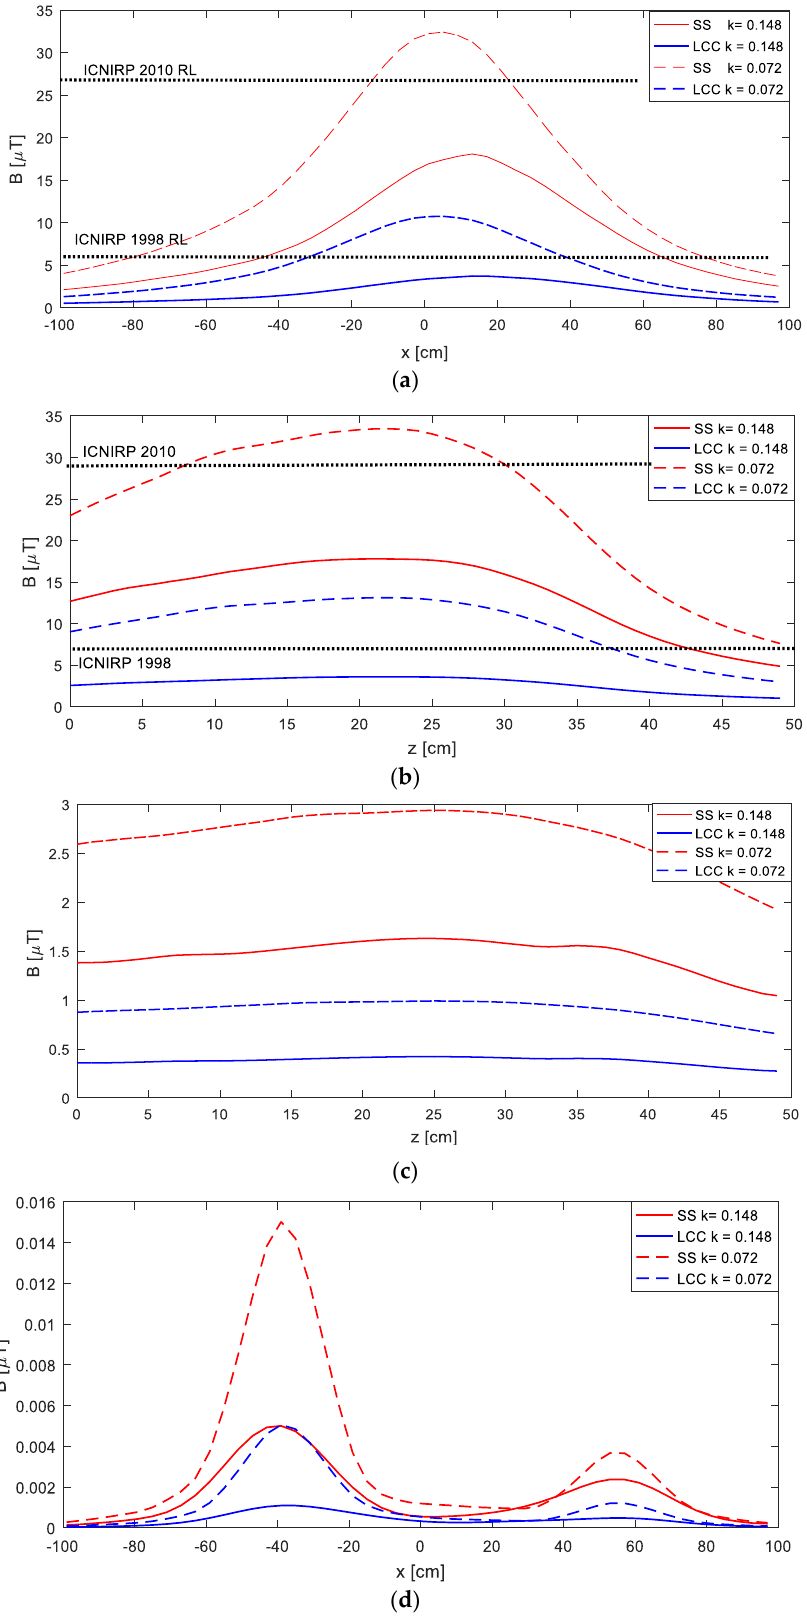
Figure 19. Magnetic flux density B calculated on the lines l 1 ( a ), l 2 ( b ), l 3 ( c ), and l 4 ( d ).